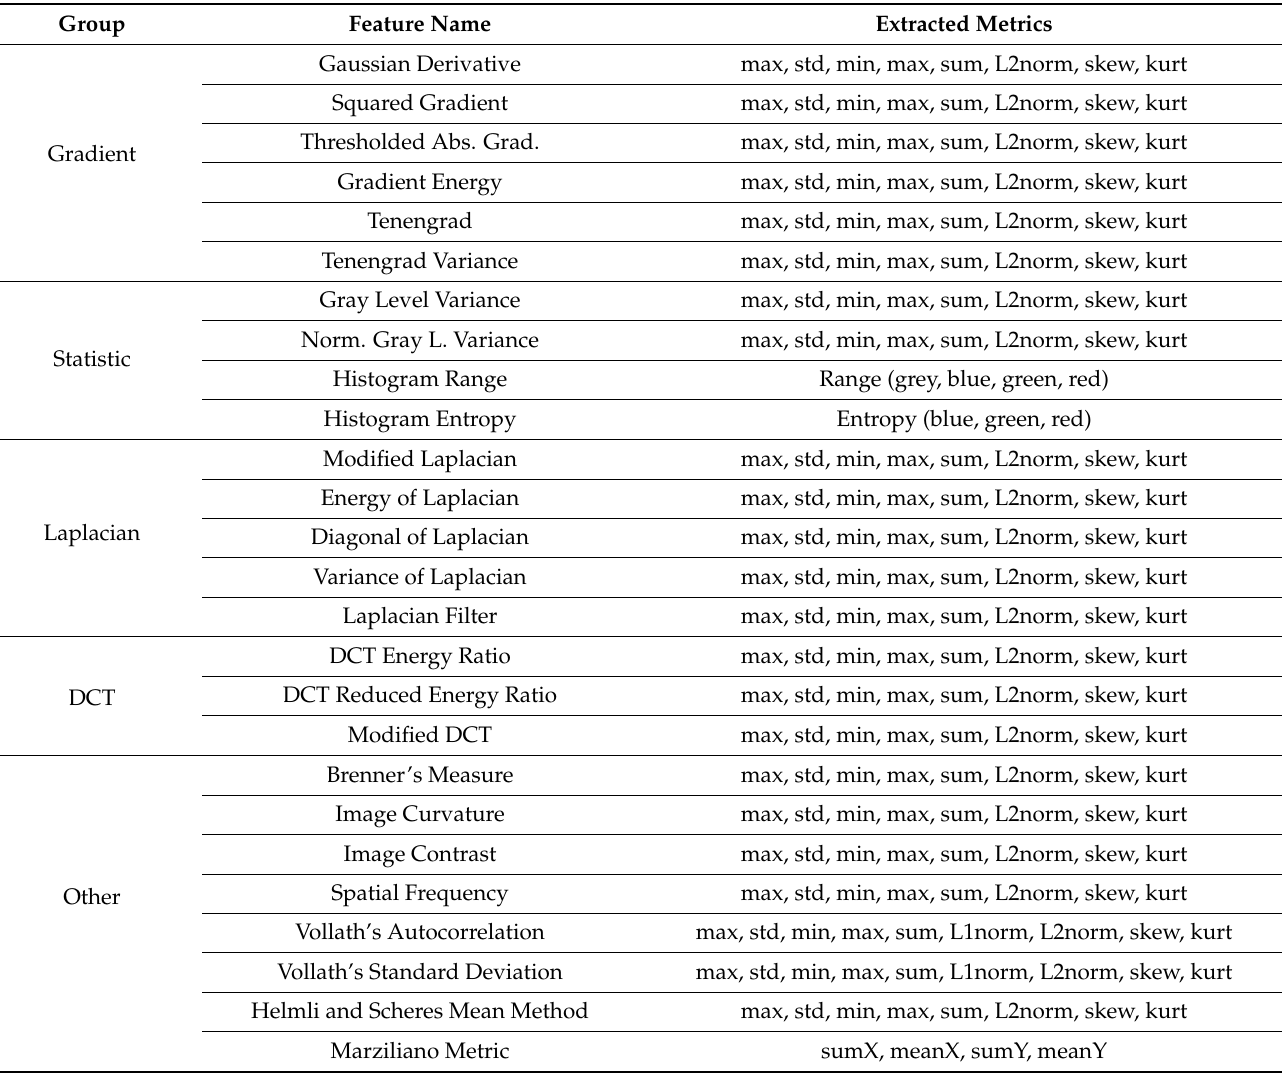
Table 4. Summary of the features extracted for focus